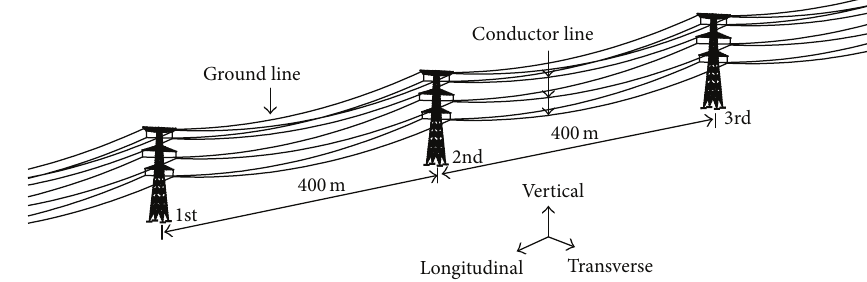
Figure 1: Finite element model of transmission line structures.